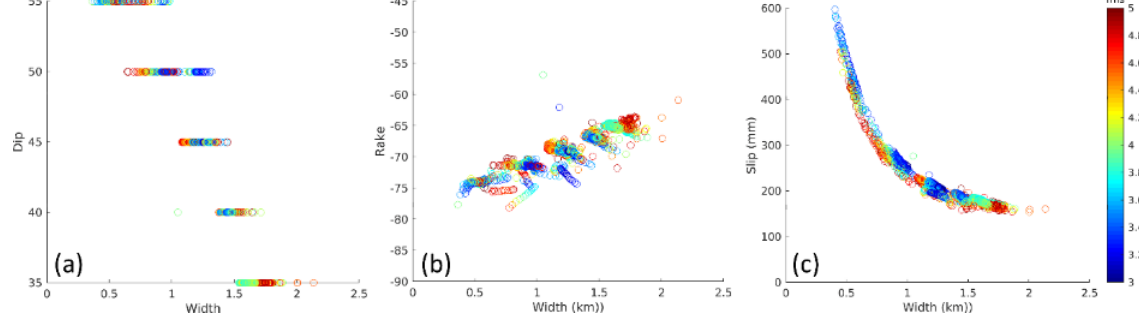
Figure A2. Divergence diagrams of the set of control group of inversions for ( a ) planar position, ( b ) X in UTM, ( c ) Y in UTM and ( d – g ) for depth, length, azimuth and dip angle, accordingly (all versus standard deviation). Color-coding refers to the inversion number.